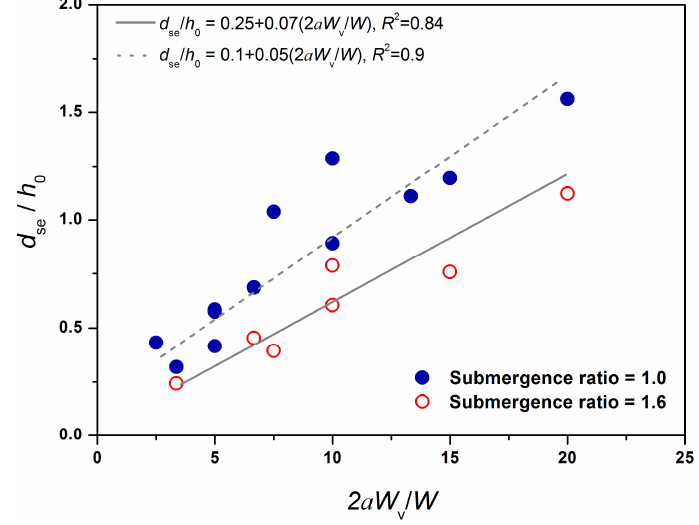
Figure 6. Maximum scour depth versus flow blockage.